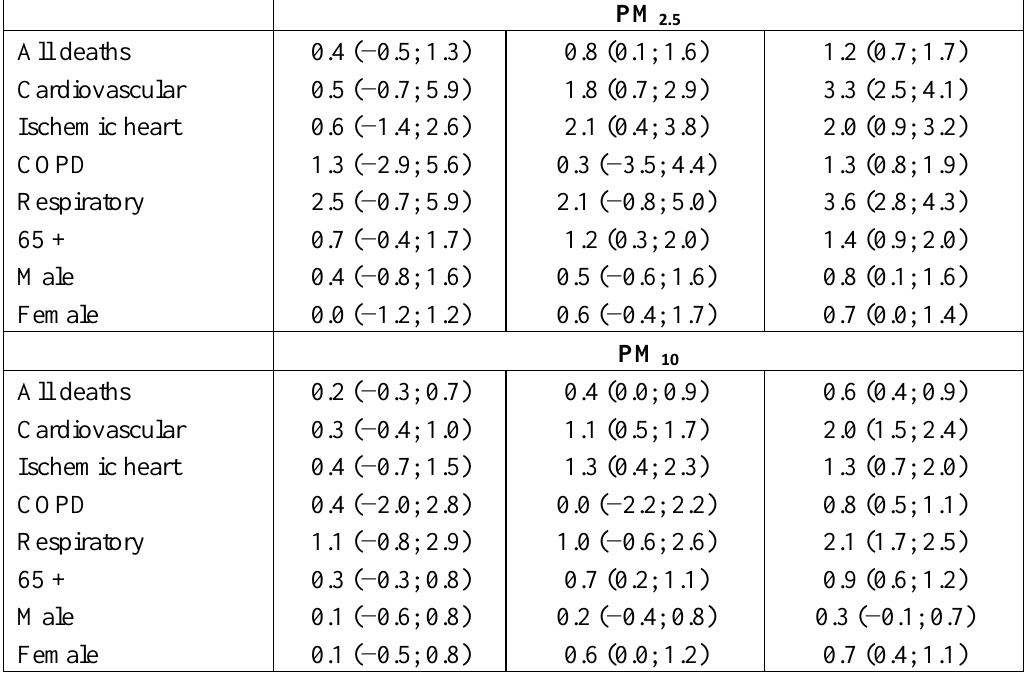
was calculated from 10